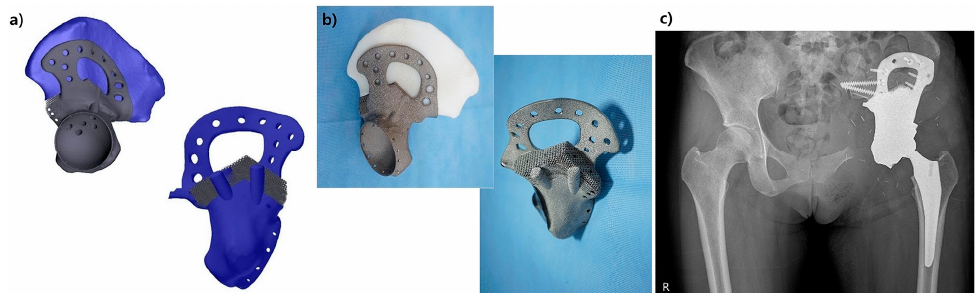
Figure 13. Pelvic implant manufactured by metal 3D printing for a 35-year-old woman who received surgery for Ewing sarcoma of the left pelvis. ( a ) Designs and ( b ) photographs revealed that the pelvic implant has both solid and lattice structures. ( c ) A postoperative plain radiograph of the applied pelvic implant. Reprinted with permission from Ref. [181]. Copyright 2022, copyright Park J, Park H, Kim J, Kim H, Yoo C, Kang H.